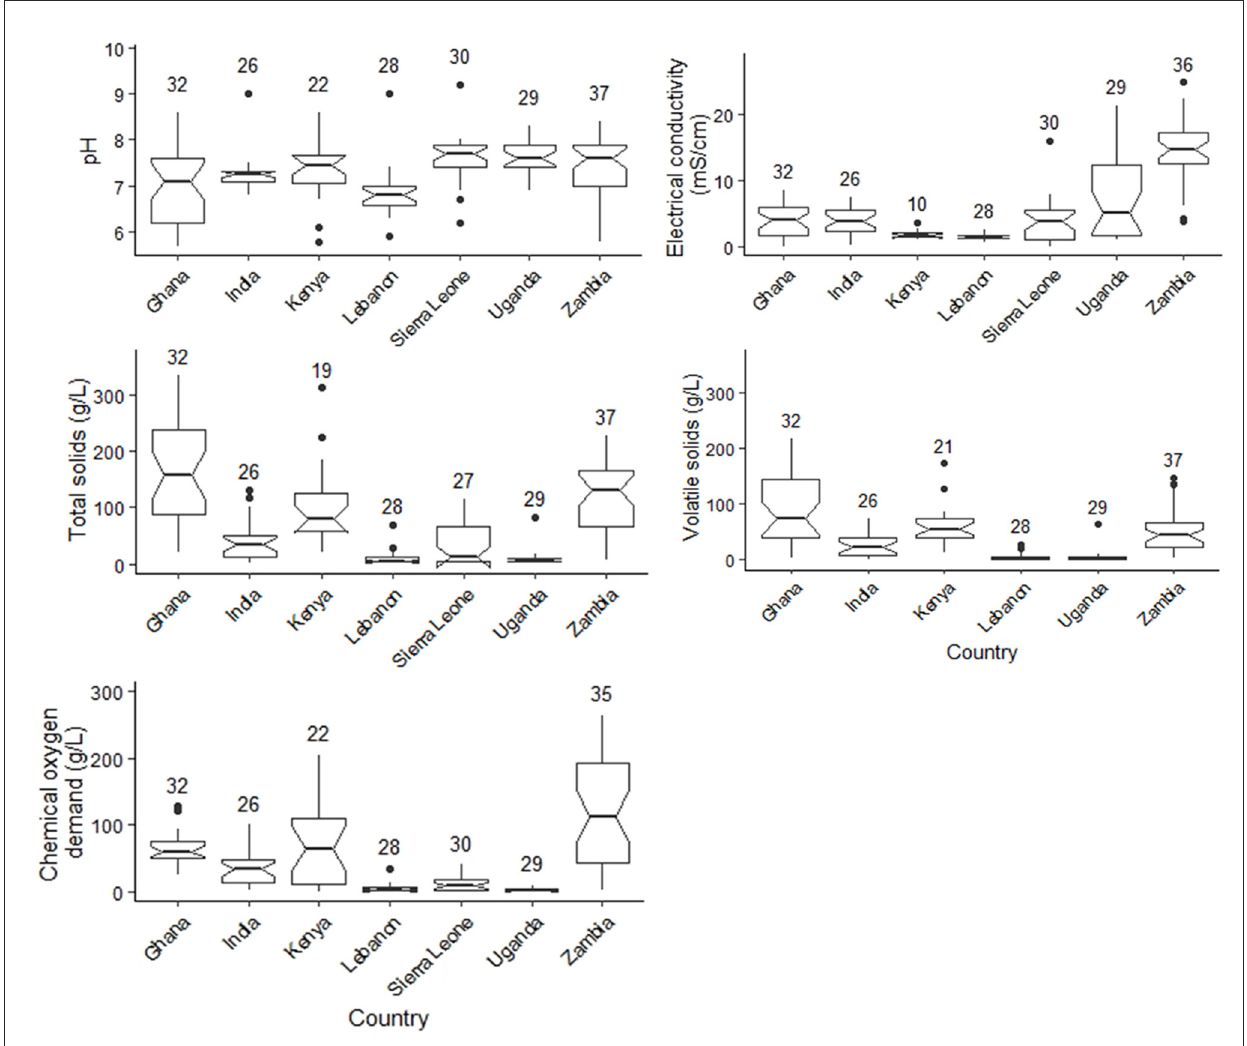
FIGURE3 Characteristics of fecal sludge per location. The number above each boxplot represents the number of samples in that category ( n ), notches in boxplots show confidence interval around the median.